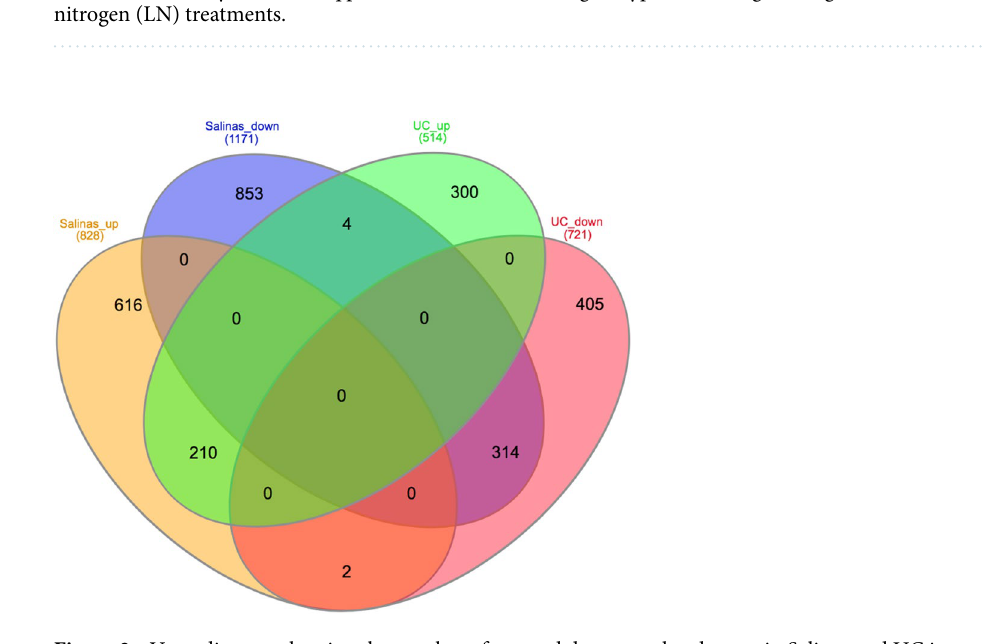
Figure 2. Venn diagram showing the number of up- and down regulated genes in Salinas and UC in response to nitrogen